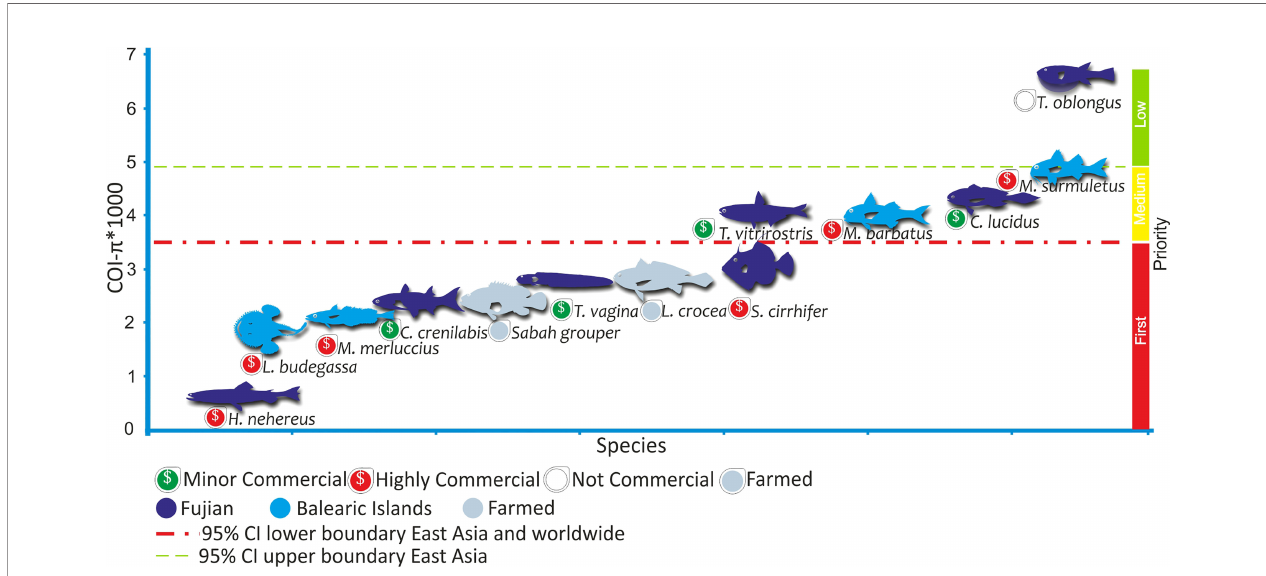
FIGURE 1 | Levels of genetic diversity in COI mitochondrial gene (COI- p ) of fi sh species. Species were ordered by their levels of COI- p and these were multiplied by 1,000 for graphical purposes. The red line shows the lower boundary of the 95%CI of the distribution of median genetic diversities values obtained by bootstrapping worldwide and East Asian fi sh datasets. The green line shows the upper boundary of the 95%CI of the median distribution of genetic diversity in East Asian fi sh. The upper-boundary of worldwide dataset was 0.004, while the 95%CI for Mediterranean species was 0.0028-0.0042 ( Supplementary Table S3 ). Fish from Fujian are the evaluated species (dark blue) in this study. Both, fi sh from Balearic Islands (light blue) and farmed (grey) fi shes were used as controls, as fi sh from the Balearic Islands are long-term managed species with known population dynamics, and the two farmed fi sh are expected to have low levels of genetic diversity. Highly commercial species are under fi shing pressures in their whole distribution while fi shing pressures are variable for minor commercial species. Credits for fi sh silhouettes: Gaston